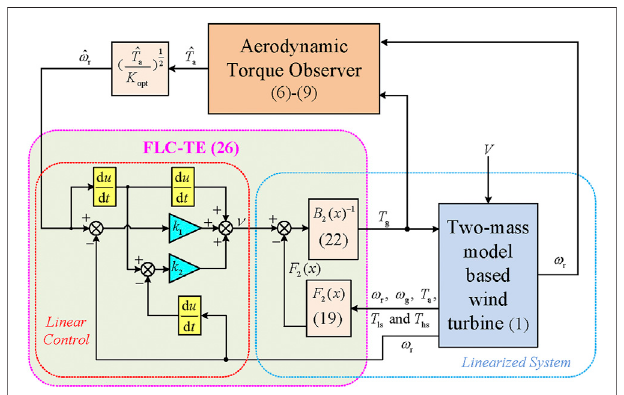
FIGURE 1 | The overall control block diagram of the proposed FLC-TE.